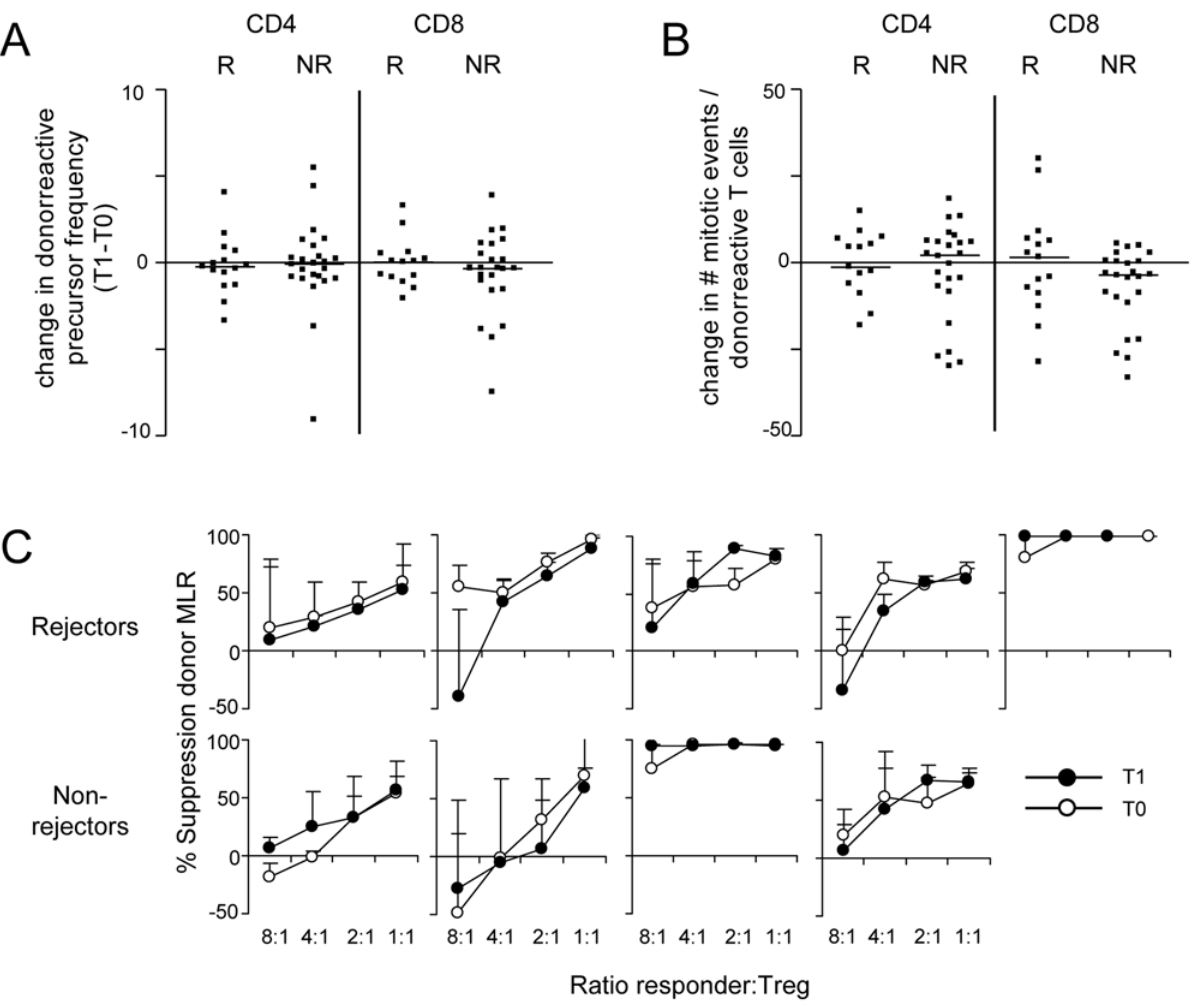
Figure 5. Changes in the functional capacity of T cells isolated from the peripheral blood of transplant patients between the time of transplantation (T0) and the start of tacrolimus withdrawal (T1). A positive value indicates an increase and a negative value indicates a decrease of the value in time. A CFSE MLR in combination with Modfit LT TM software was used to calculate the precursor frequency and the number of mitotic events of allo- and 3 rd -party-reactive CD4 + and CD8 + T cells. (A) The change (y-axis) in the precursor frequency of alloreactive CD4 + and CD8 + T cells. (B) The change in the number of mitotic events (ME) of CD4 + and CD8 + alloreactive T cells. (C) The functional capacity to suppress anti- donor responses of Treg isolated before transplantation (T0, white circles) and before the start of tacrolimus reduction (T1, black circles) in 5 rejectors (upper graphs) and 4 non-rejectors (lower graphs).